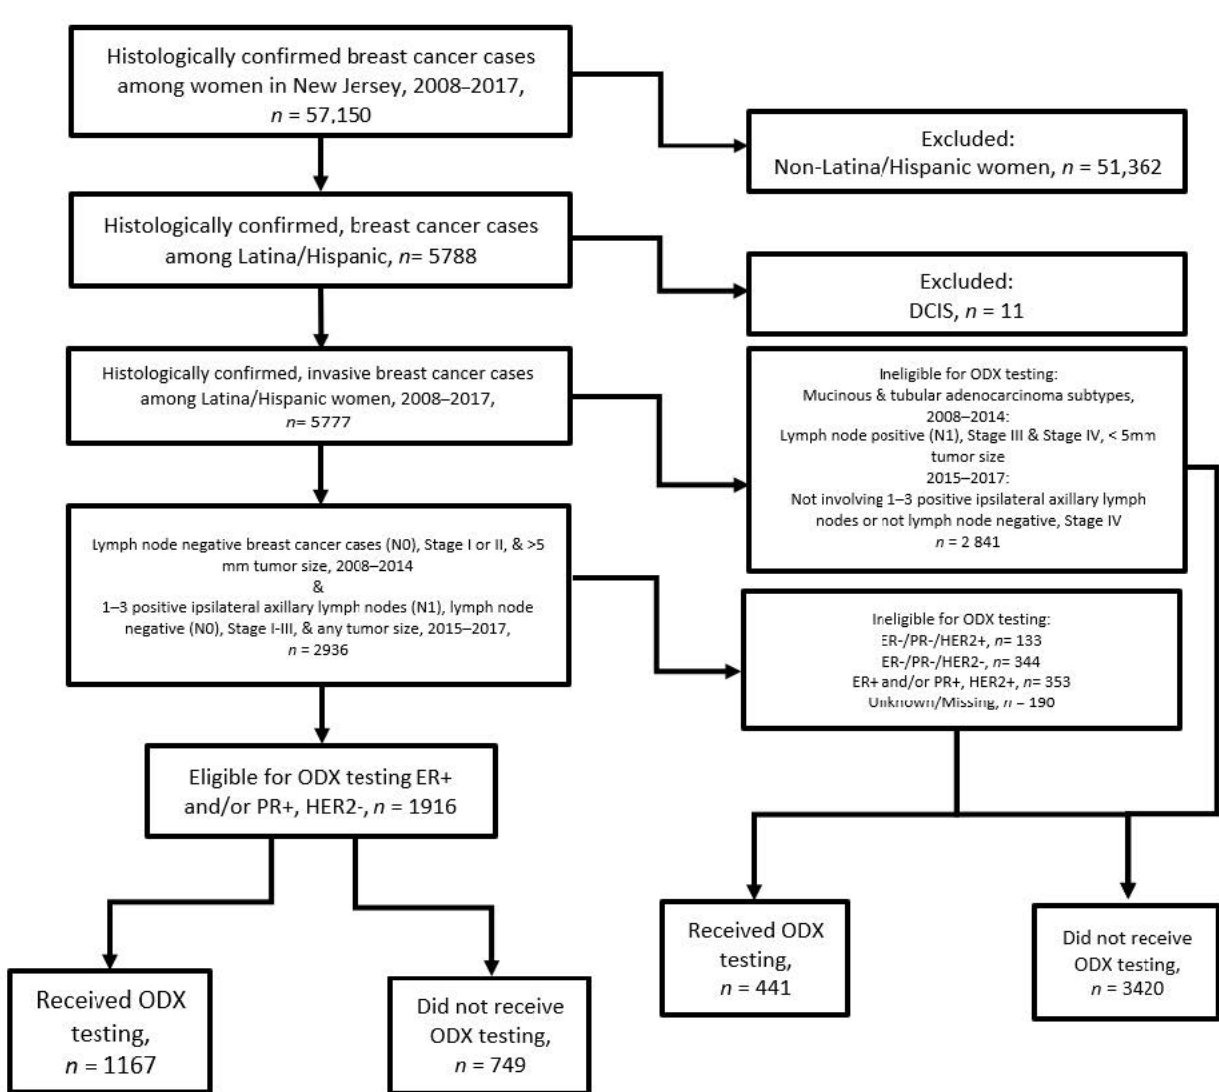
Figure 1. Flow diagram depicting assembly of the analytic sample.